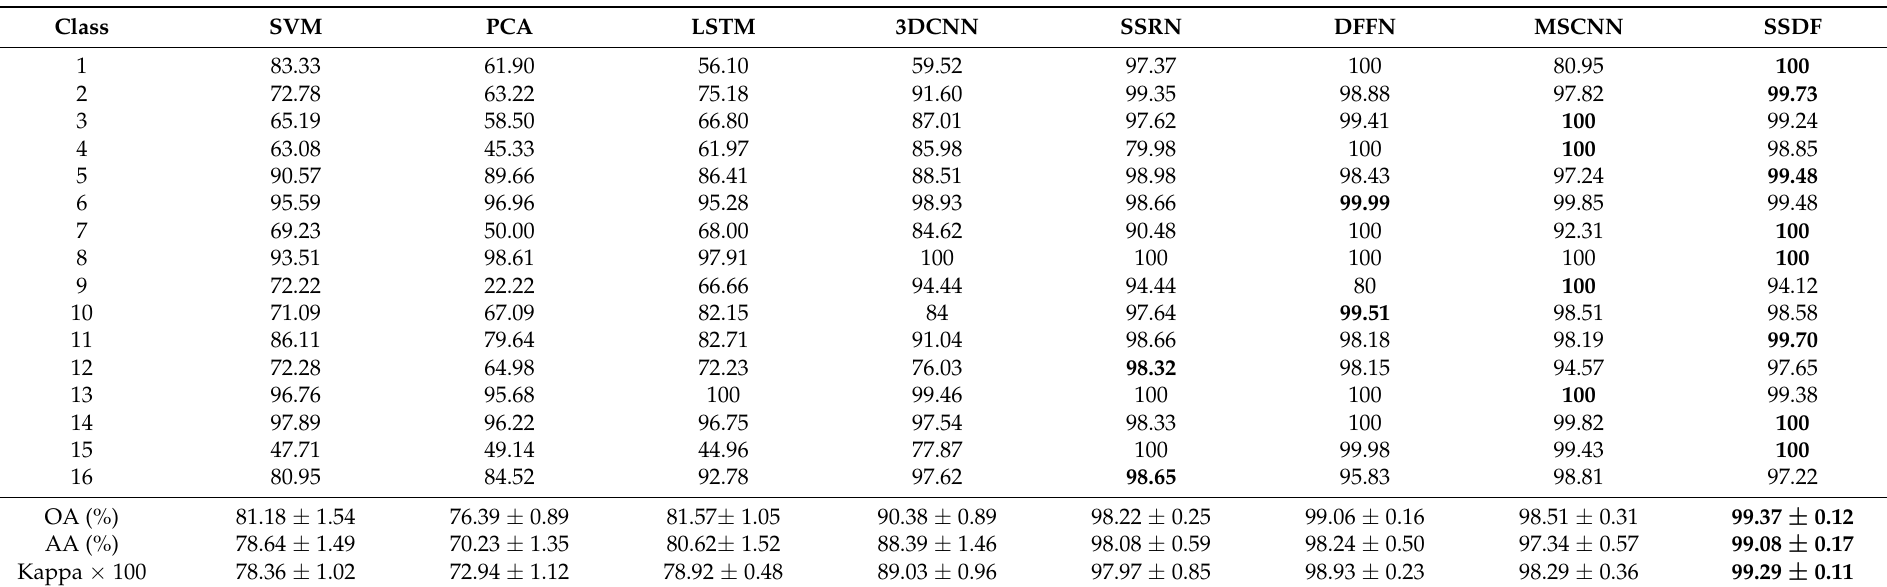
Table 4. The classification results of all methods on the Indian pine dataset with OA, AA and Kappa data given in the form of mean ± standard deviation. Legend: SVM, support vector machine; PCA, principal component analysis and SVM with Radial Basis Function (RBF-SVM); LSTM, long short-term memory network; 3DCNN, three-dimensional convolutional neural network; SSRN, spectral–spatial residual network; DFFN, deep feature fusion network; MSCNN, multi-scale spatial features and cross-domain convolutional network; and SSDF, spectral–spatial classification method based on deep adaptive feature